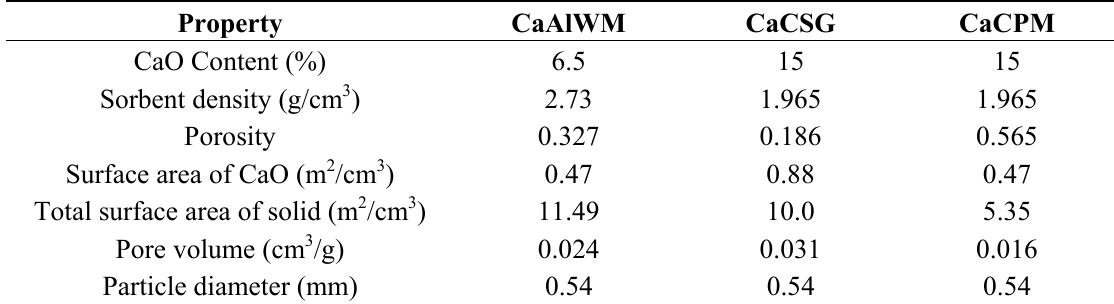
Table 1. Properties of the studied CaO based sorbents.